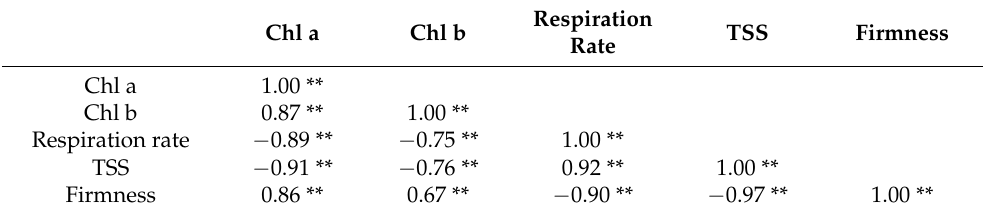
Table 3. Correlations between Chl a, Chl b, respiration rate, TSS, and firmness of banana fruits. Respiration Chl a Chl b TSS Firmness Rate Chl a 1.00 ** Chl b 0.87 ** 1.00 ** Respiration rate − 0.89 ** − 0.75 ** 1.00 ** TSS